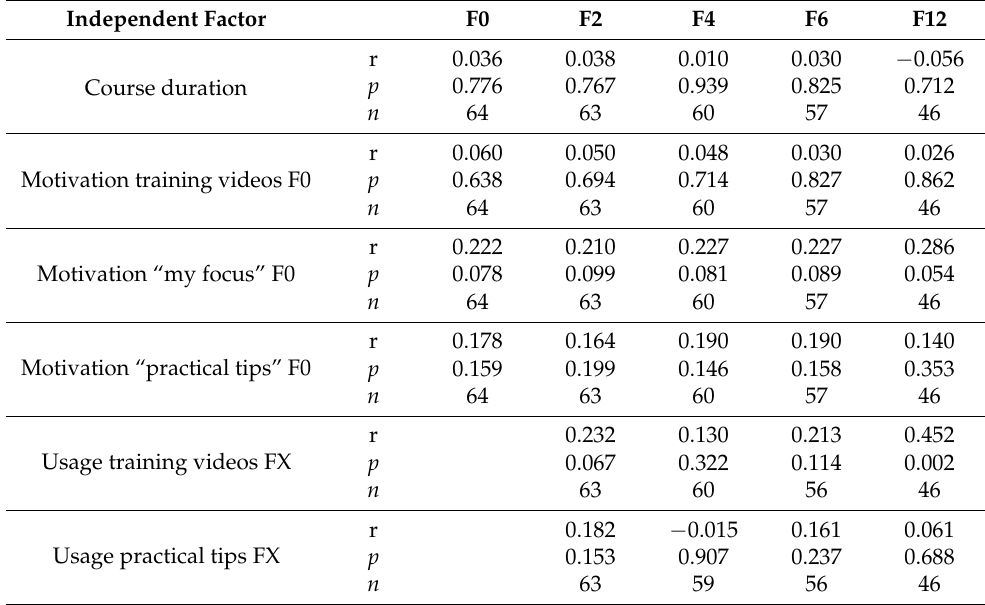
Table A8. Spearman-Rho Test for measuring correlations: Influence of different factors on the effect of the app on the BMI at the measurement